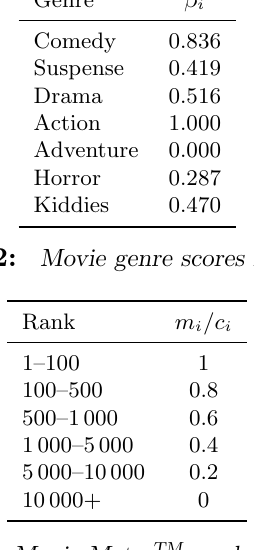
Table 3: Movie Meter TM rank